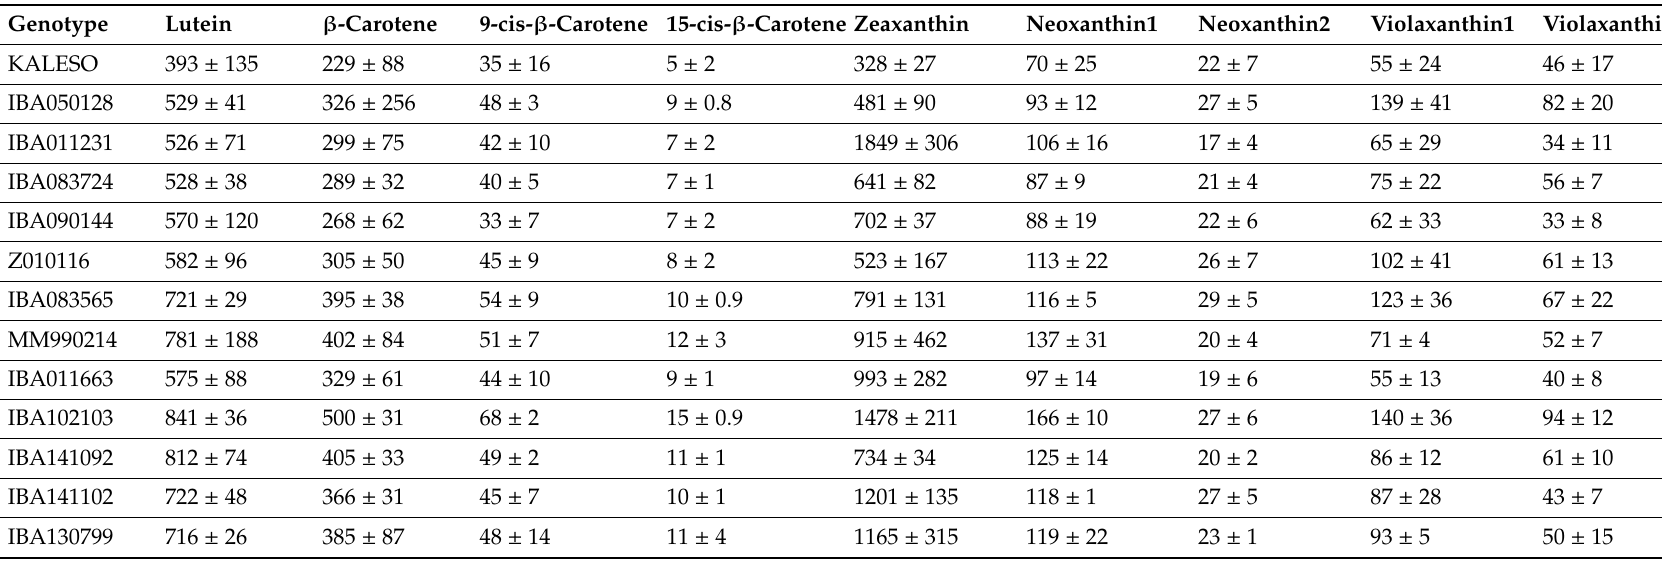
Table 2. Carotenoid composition of leaf carotenoids ( µ g g − 1 leaf dry weight). Three plants per genotype were analyzed. Variation between samples is given as